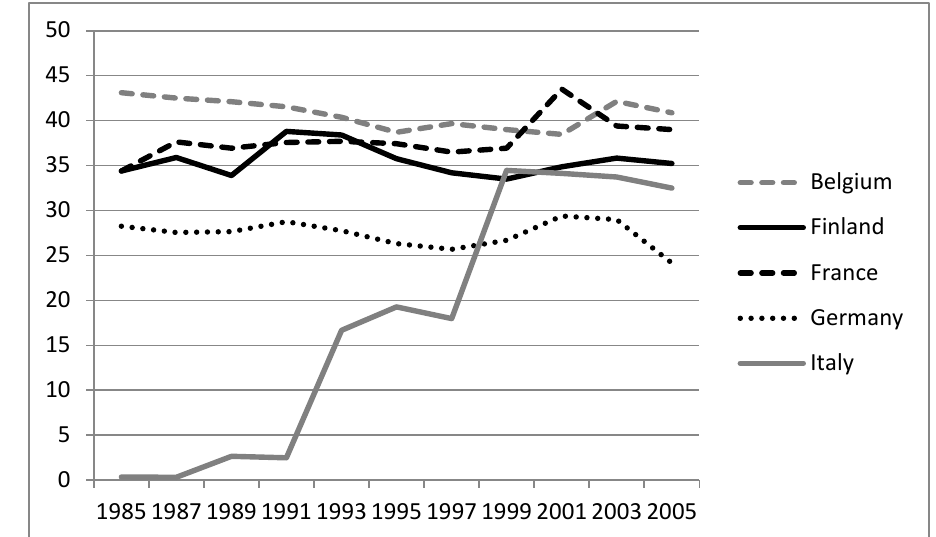
Figure 1 : Gross replacement rates during